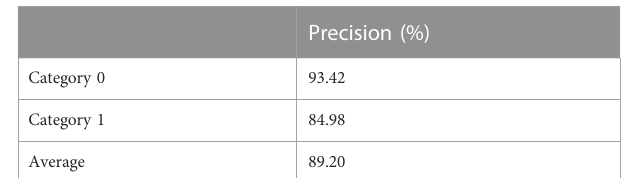
TABLE 2 Recognition